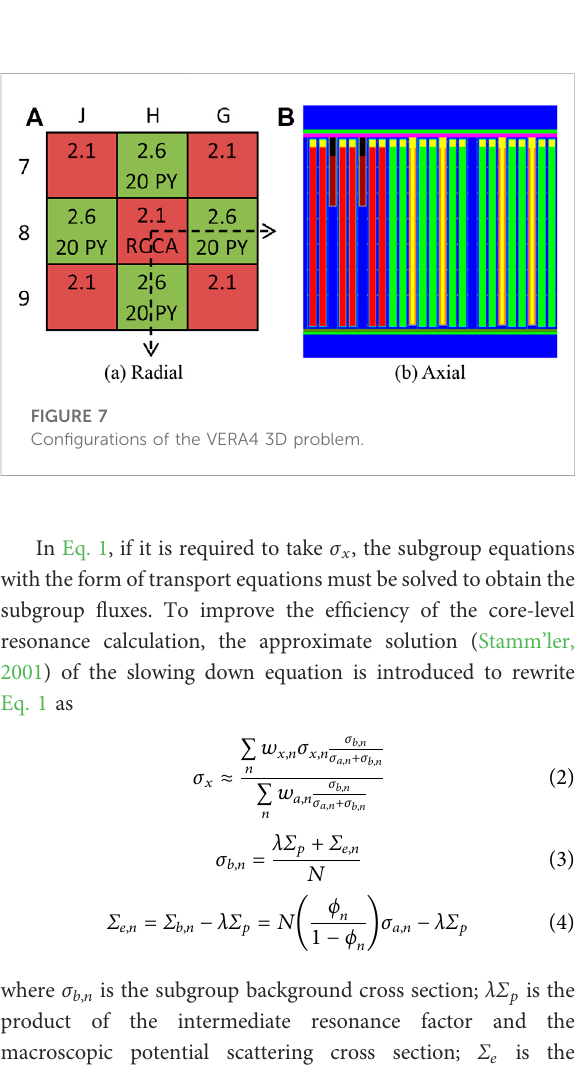
solving the subgroup equations.